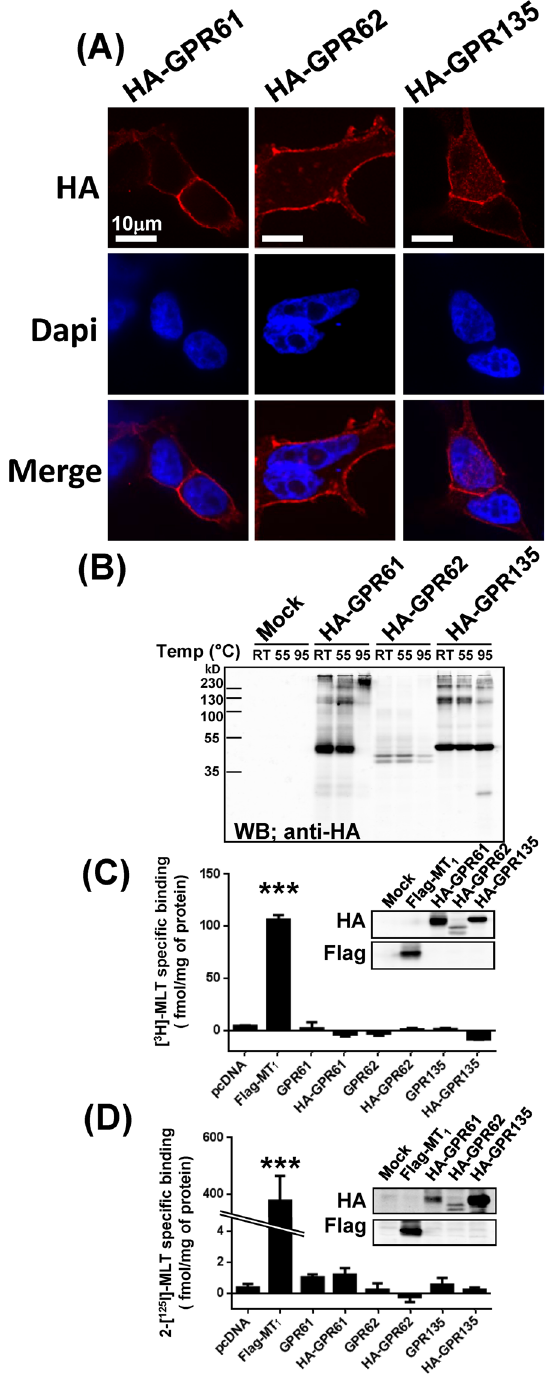
Figure 1. Expression and [ 3 H]-MLT and 2-[ 125 I]-MLT binding to HA-GPR61, HA-GPR62 and HA-GPR135 expressed in HEK293T cells. ( A ) The expression of HA-tagged (N-terminal) GPR61, GPR62 and GPR135 at the cell surface of intact HEK293T cells was detected by confocal microscopy with anti-HA antibodies. ( B ) Expression of HA-GPR61, HA-GPR62 and HA-GPR135 in crude membranes prepared from HEK293T cells was monitored by western blot. Different denaturating conditions were applied: RT; room temperature overnight, 55 °C 15 min, or 95 °C 10 min, all in the presence of DTT. ( C , D ) Binding of [ 3 H]-MLT ( C ) and 2-[ 125 I]-MLT ( D ) to crude membrane prepared from HEK293 cells expressing HA-tagged or untagged GPR61, GPR62 or GPR135. Expression of HA-tagged receptors was verified by western blot (insets). Flag-MT 1 was used as positive control. Representative results are shown for panels A and B; similar results were obtained in three additional experiments. Data in panels C and D represent the mean ± SEM of three independent experiments performed in duplicates. *** P <